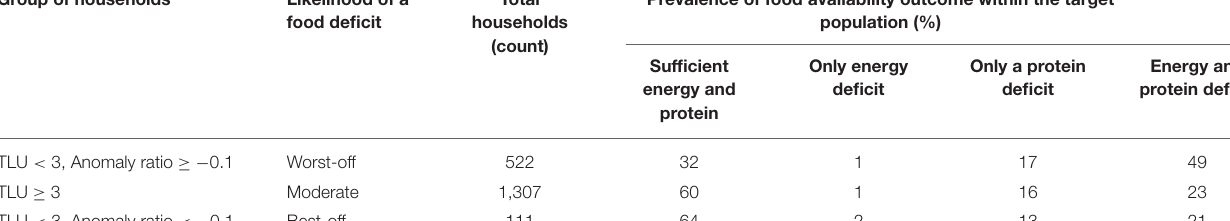
TABLE 2 | Food availability status by target population in Ethiopia. Group of households